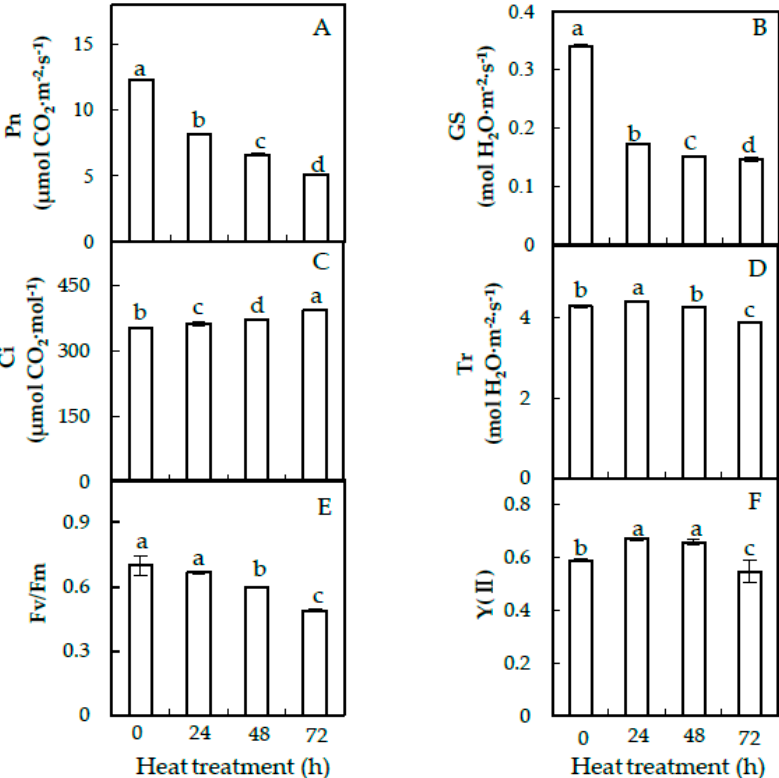
Figure 2. Photosynthetic characteristics and chlorophyll fluorescence parameters in leaves of spinach Sp73 under the heat-stress treatment. ( A ) Photosynthesis rate (Pn); ( B ) stomata conductance (Gs); ( C ) intercellular CO 2 (Ci); ( D ) transpiration rate (Tr); ( E ) Photosystem II (PSII) maximum quantum yield (Fv/Fm); ( F ) effective PSII quantum yield (Y(II)). The values were determined after plants were treated with heat stress at 37 °C/32 °C (day/night) for 0 h, 24 h, 48 h and 72 h and are presented as means ± SD ( n = 3). The different small letters (a–d) indicate significant difference ( p < 0.05) in different